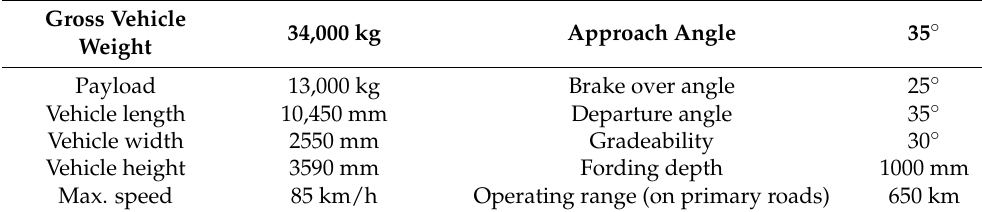
Table 3. Basic technical data of tested 8 × 8 vehicle.